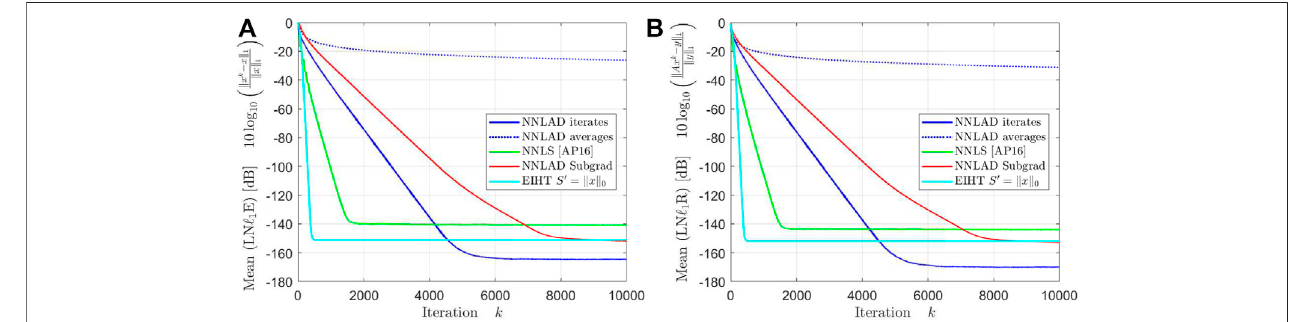
FIGURE 5 | Convergence rates of certain iterated methods with respect to the number of iterations.